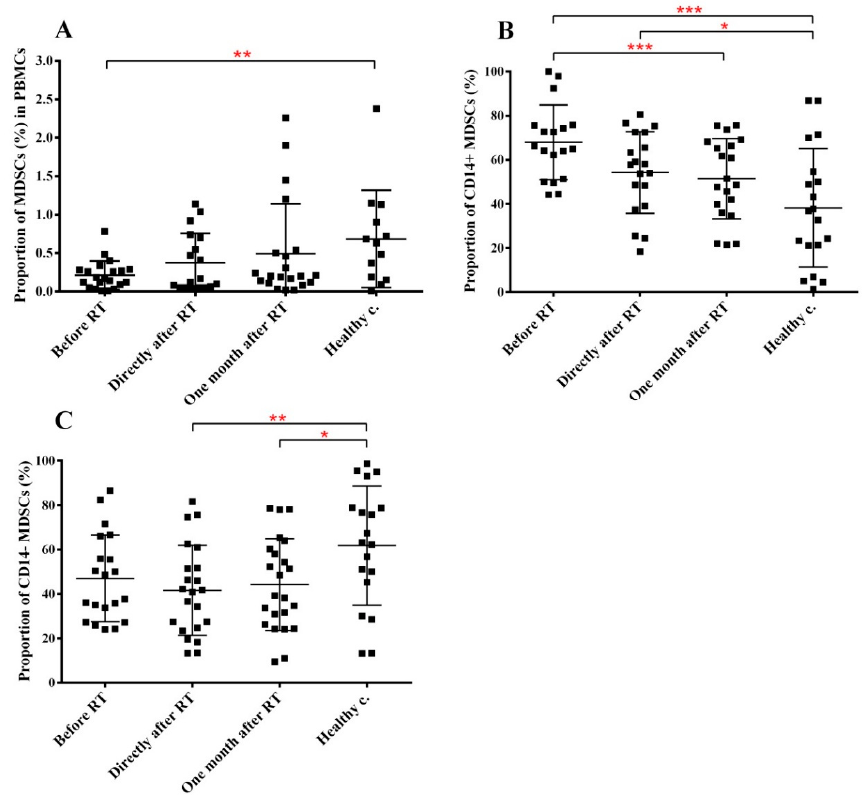
Figure 6. The fraction of MDSCs decreases in the peripheral blood of H&N cancer patients and this decrease is maintained after RT, as well. PBMCs were isolated from RT-treated H&N cancer patients, processed and labelled with the corresponding antibodies for identifying MDSCs as described in the Materials and methods section. We investigated two subpopulations of MDSCs. ( A ) fraction of MDSCs in PBMCs. ( B ) fraction of CD14 + subpopulation within all HLA-DR- cells. ( C ): fraction of CD14 − subpopulation within all HLA-DR- cells. Student’s paired t -test was used to test significant differences among the three time points of cancer patients’ samples, while unpaired t -test was used to test significant differences between the three time points and healthy control group using 95% confidence interval. Data are shown as individual data points together with the mean ± SD (cancer patients n = 23, healthy controls n = 15). Significant differences were indicated with * ( p < 0.05), ** ( p < 0.01), *** ( p < 0.001) and **** ( p < 0.0001).